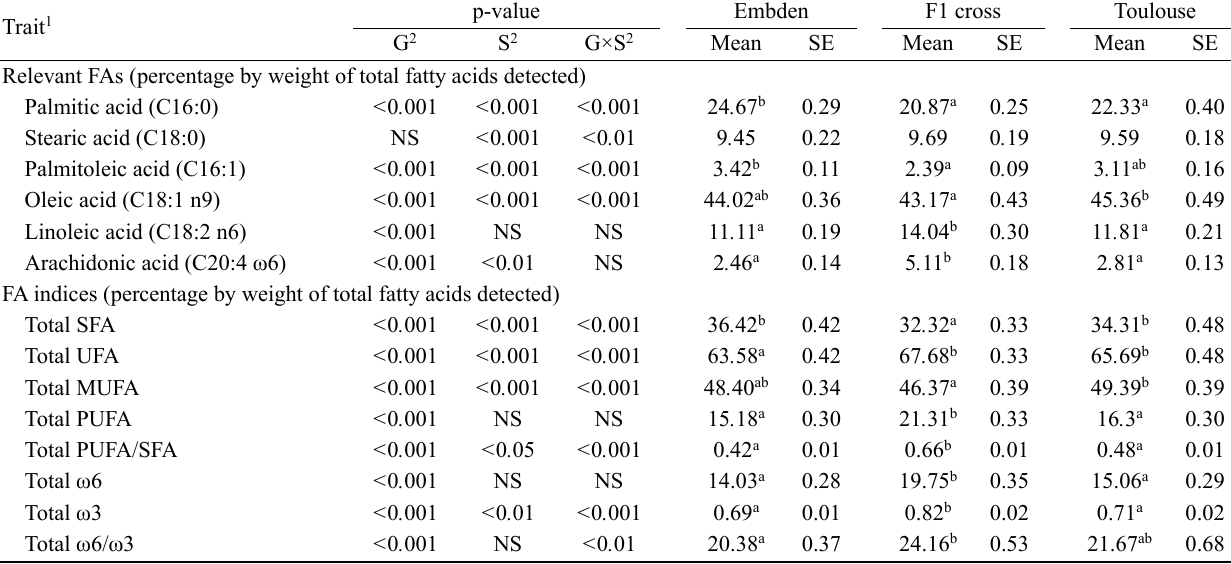
Table 5. ANOVA and descriptive parameters (mean and SE) of the main fatty acid traits for the three genetic goose groups raised in the dehesa system analyzed p-value Embden F1 cross Trait 1 Relevant FAs (percentage by weight of total fatty acids detected)